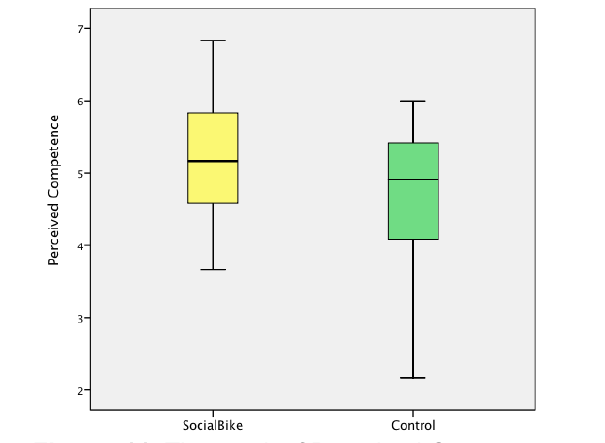
Figure. 11. The result of Perceived Competence (ranges from